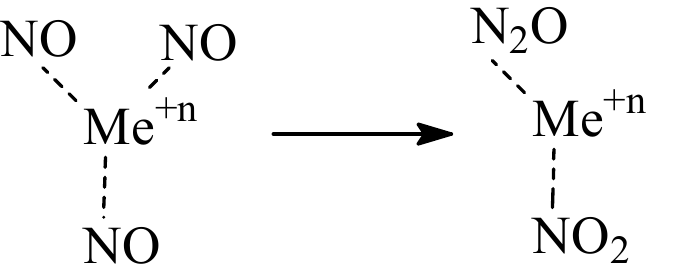
Scheme 2. NO complexes and their transformations on cationic forms of